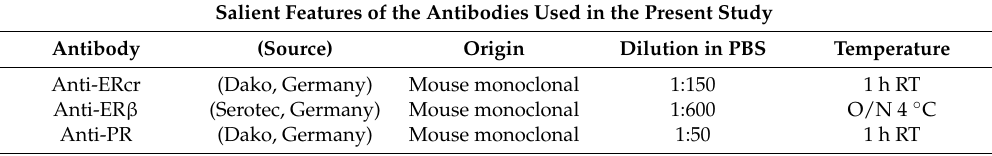
Table 1. Antibodies used for expression analysis of steroid hormone receptors.